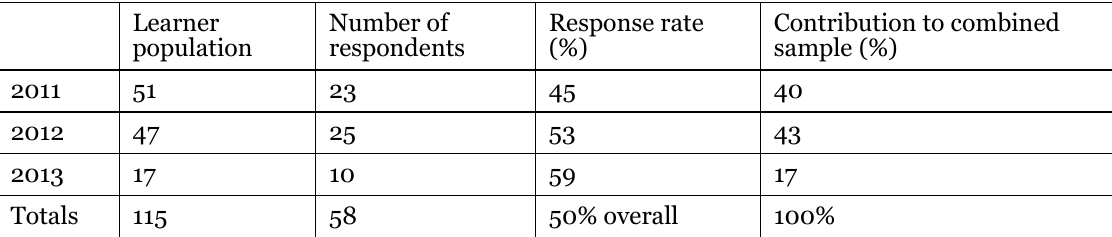
Three-Cohort Sample